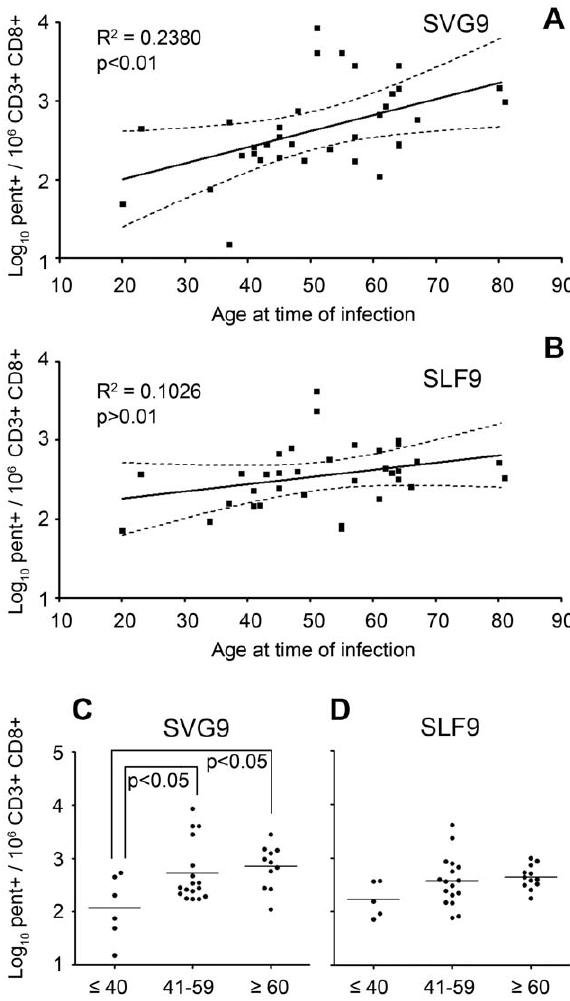
Figure 2. Frequency of SVG9 but not SLF9 specific cells increase with age. Log 10 frequency of p-MHC multimer positive cells specific for SVG9 (A) and (B) SLF9 WNV epitopes vs age. The linear regression model is shown with the 95% confidence bands. Log 10 frequency of SVG9 (C) and SLF9 (D) p-MHC multimer positive cells were divided into three age groups: subjects # 40, 41–59, and $ 60 at time of infection. For (C) data did not fit a normal distribution so a Kruskal- Wallis ANOVA was used with Dunn’s method of comparative analysis and medians are shown.